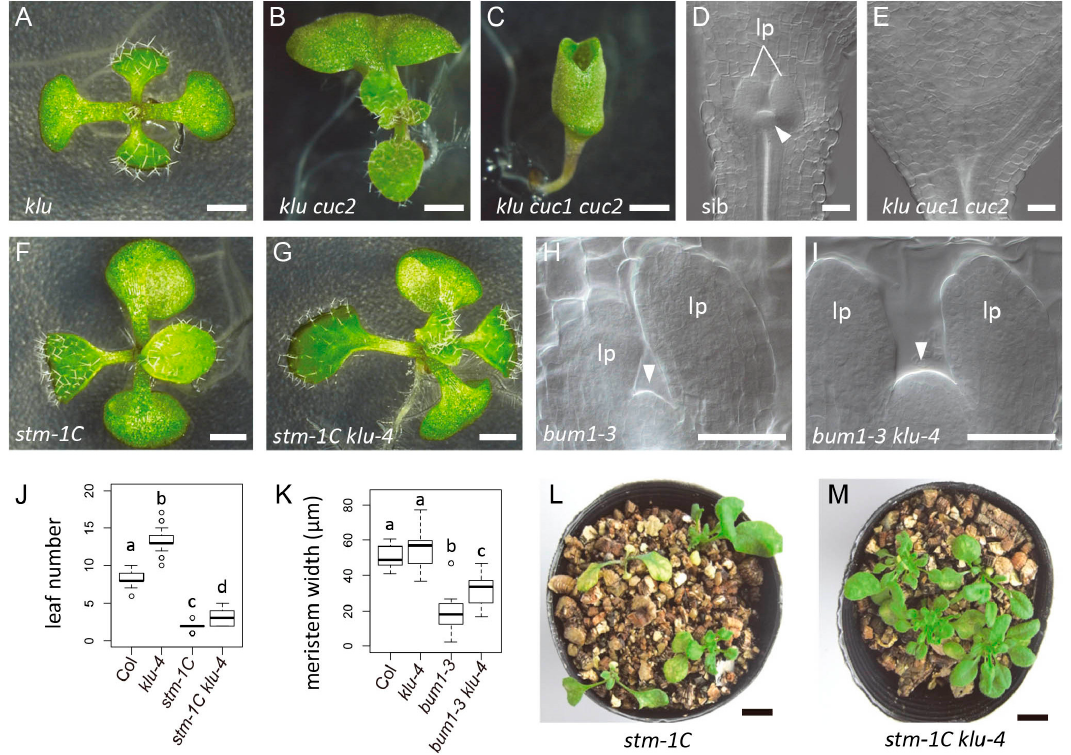
Figure 5. KLU acts downstream of CUC1 and CUC2 , and counteracts STM in the regulation shoot meristem activity. ( A – C ) Seven ‐ day ‐ old seedlings of klu ‐ 4 ( A ), klu ‐ 4 cuc2 ‐ 3 ( B ), and klu ‐ 4 cuc1 ‐ 5 cuc2 ‐ 3 ( C ). ( D , E ) Shoot apices of the progeny from klu ‐ 4 cuc1 ‐ 5 cuc2 ‐ 3 / + parent plants. A sib seedling with the shoot meristem ( D ) and a klu cuc1 cuc2 seedling without it ( E ). ( F , G ) Nine ‐ day ‐ old seedlings of the strong stm allele stm ‐ 1C ( F ) and stm ‐ 1C klu ‐ 4 ( G ). ( H , I ) Shoot apex of the weak stm allele bum1 ‐ 3 ( H ) and bum1 ‐ 3 klu ‐ 4 ( I ) at 4 dag. ( J ) Leaf number at 11 dag. ( K ) Shoot meristem width at 4 dag. ( L , M ) Twenty ‐ nine ‐ day ‐ old plants of stm ‐ 1C ( L ) and stm ‐ 1C klu ‐ 4 ( M ). Four plants are grown in each pot. Different letters in box plots indicate statistically significant differences ( p < 0.01, Steel–Dwass method for J ; p < 0.05, Tukey–Kramer method for K ). Sample size is 55, 30, 24, and 14 for J ; 14, 18, 15, and 9 for K . Arrowheads indicate the shoot meristem. lp, leaf primordia. lp, leaf primordia. Scale bar, 1 mm for A to C , F , and G ; 50 μ m for D , E , H , and I ; 10 mm for L and M .